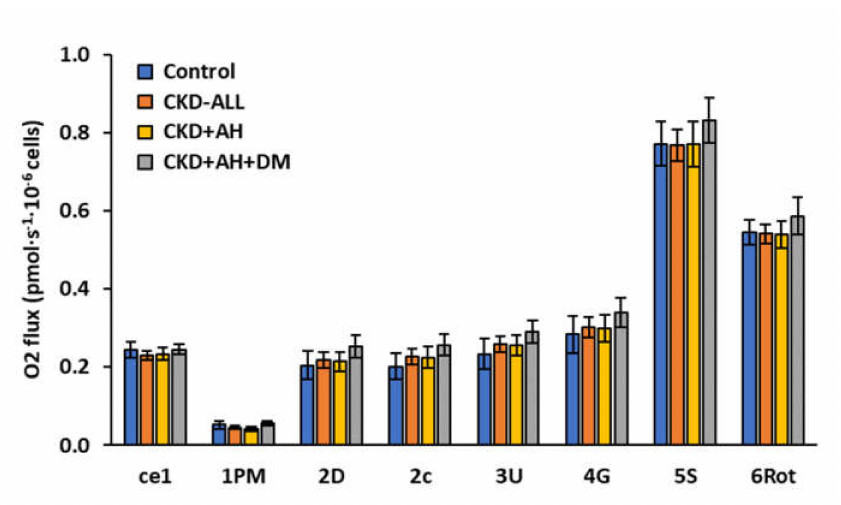
Figure 2. Platelet mitochondrial function in control subjects and groups of CKD patients. Legend: The parameters of mitochondrial respiration in human platelets. The bars show mean ± SEM. The names on the x-axis represent steps in the SUIT RP1—see the legend for Figure 1 in the Methods section. Control—the group of healthy subjects ( n = 12); CKD-ALL—all patients with chronic kidney disease ( n = 27); CKD and arterial hypertension (CKD + AH)—the subgroup of CKD-ALL patients with arterial hypertension ( n = 17); and CKD + AH + diabetes mellitus (DM)—the subgroup of CKD-ALL patients with arterial hypertension and diabetes type 2 ( n =